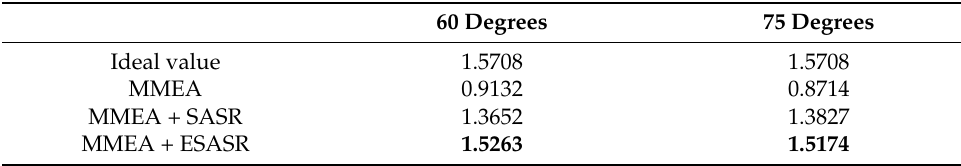
Table 2. Comparison of distortion angle.